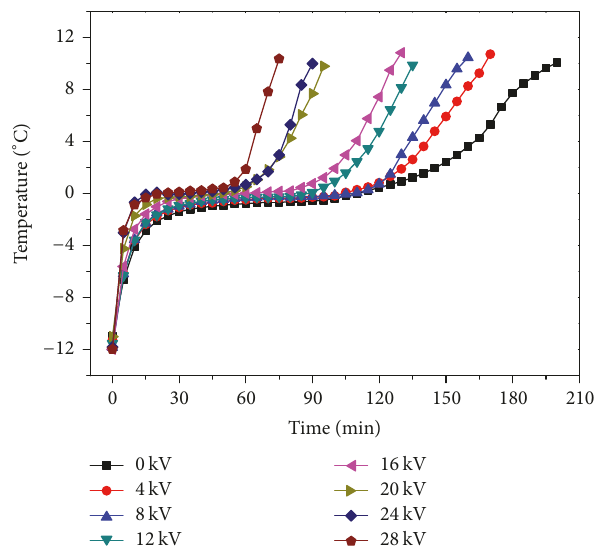
Figure 3: Changes in temperature during thawing of frozen tofu in different voltages.